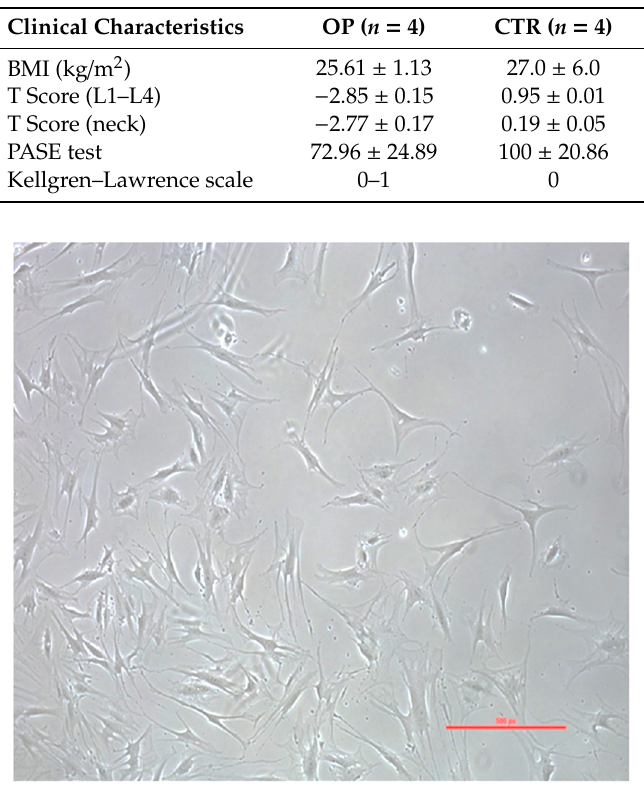
Figure 1. Primary human osteoblast cultures were observed under phase-contrast microscope at 10 × field. Scale bar: 500 μ m .